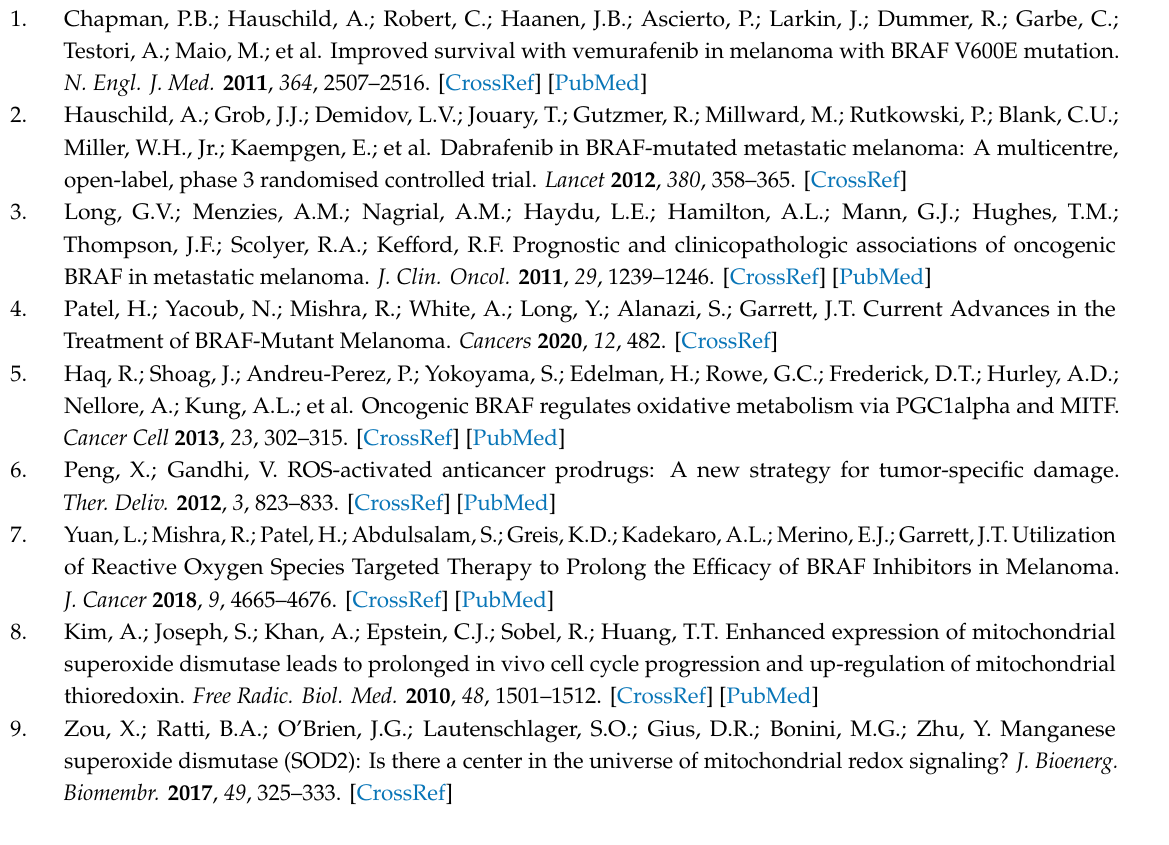
Figure S1: Whole blot image of PRDX1 in WM-115, WM-115 DR, WM-115 TDR from Figure, Figure S2: Whole blot image of SOD2 in WM-983, WM-983 DR, WM-983 TDR, WM-115, WM-115 DR, WM-115 TDR from Figure 4, Figure S3: Whole blot image of PRDX1 in WM-983, WM-983 DR, WM-983 TDR from Figure 4, Figure S4: Whole blot image of Actin in WM-983, WM-983 DR, WM-983 TDR, WM-115, WM-115 DR, WM-115 TDR from Figure 4, Figure S5: Whole blot image of p53 in WM-115, WM-115 TDR, WM-983, WM-983 TDR from Figure 4, Figure S6: Whole blot image of Actin, CTRL SiRNA, SOD2 SiRNA in WM-983, WM-983 TDR, WM-115, WM-115 TDR from Figure 5, Figure S7: Densitometry reading of SOD2 expression in Figure 4A, Figure S8: Densitometry reading of PRDX1 expression in Figure 4A, Figure S9: Densitometry reading of SOD2 expression in Figure 4B, Figure S10: Densitometry reading of PRDX1 expression in Figure 4B, Figure S11: Densitometry reading of NF-KB expression in Figure 4C, Figure S12:. Densitometry reading of NF-KB expression in Figure 4C, Figure S13: Densitometry reading of p53 expression in Figure 4C, Figure S14: Densitometry reading of p53 expression in Figure